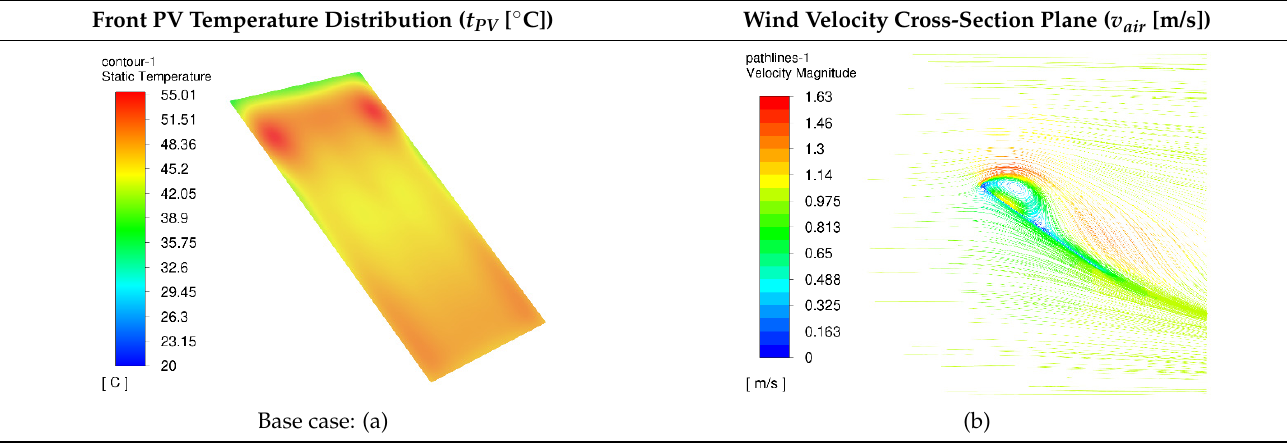
Table 5. Temperature distribution on the PV panel and air velocity profile for the NOCT configuration. Front PV Temperature Distribution ( t PV [ ◦ C]) Wind Velocity Cross-Section Plane ( v air [m/s])